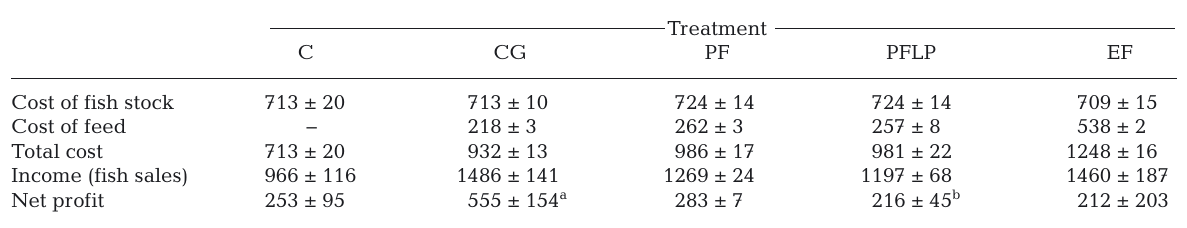
6. Cost analysis (in € ha −1 ) of common carp Cyprinus carpio culture using different feeds. C: control without supple